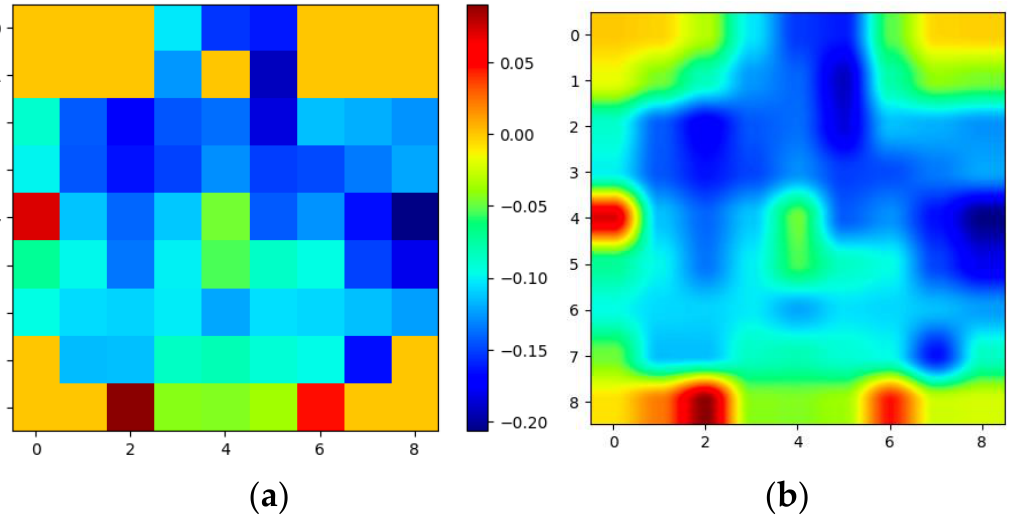
Figure 2. Illustration of spatio-temporal conversion: ( a ) 2D representation of raw EEG signals at time t; ( b ) 2D representation of EEG signals after interpolation at time t.